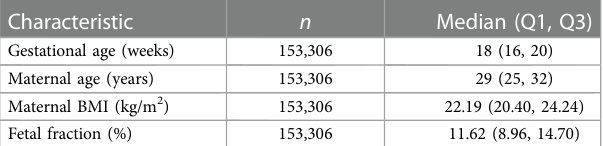
TABLE 1 Basic characteristics and fetal fraction of the study population.